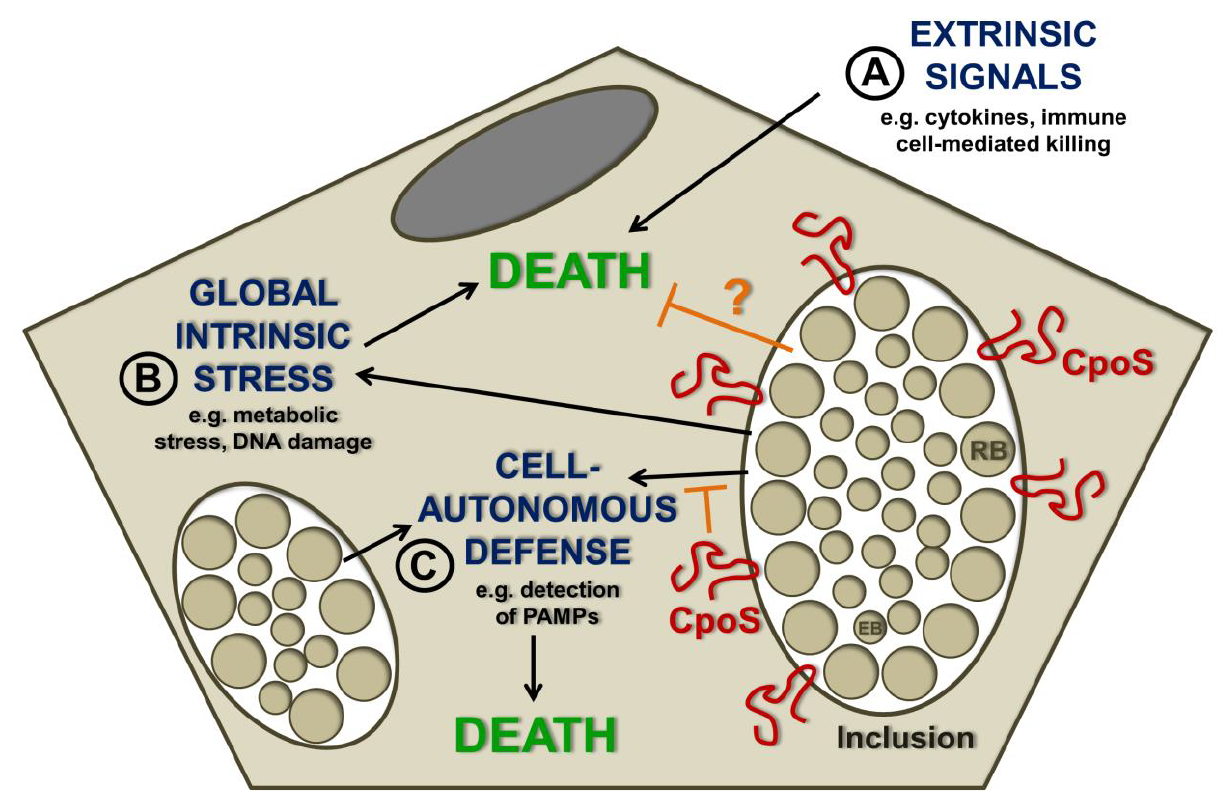
FIGURE 1: Possible sources of pro-death signals acting on Chlamydia -infected cells. (A) Inside the host, Chlamydia -infected cells are ex- posed to cytotoxic cytokines and death-inducing immune cells, but have evolved to block induction of cell death by these stimuli. (B) The ability of Chlamydia spp. to block apoptosis induced by cellular stress inducers suggests that the bacteria actually need to protect host cells from infection-induced lethal stress. (C) Cell death may be induced by activation of immune sensors that regulate cell-autonomous defense mechanisms. Our recent study demonstrated that the C. trachomatis inclusion membrane protein CpoS counteracts the activation of the PAMP sensor STING and prevents emission of pro-death signals from the